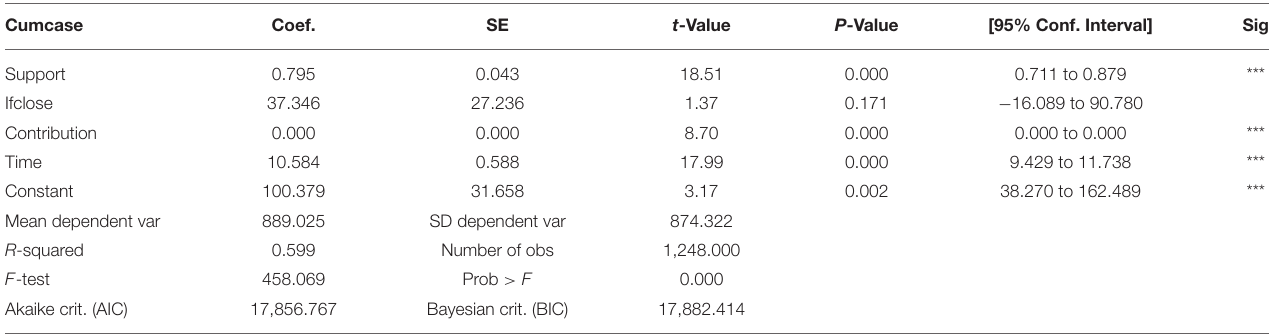
TABLE 4 | The regression results for the two-way fixed effects model of the influence of aid intensity on the cumulative number of patients.